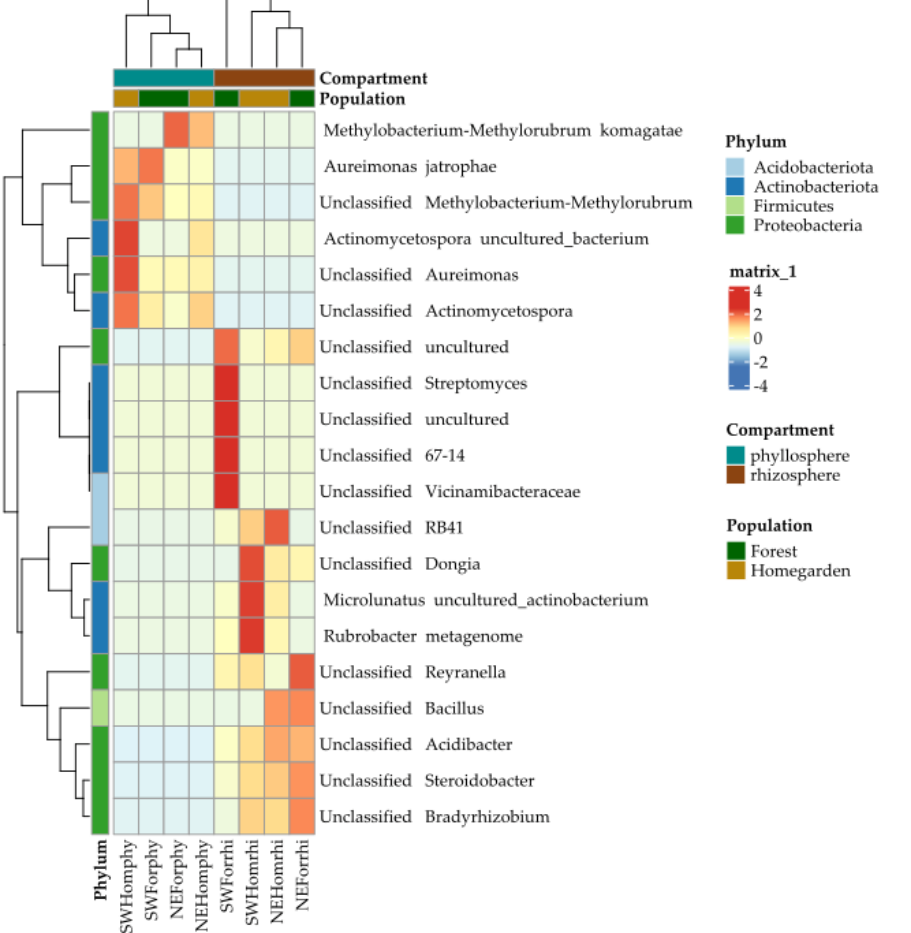
Figure 7. Heatmap of the microbiota of bacteria from the phyllosphere and rhizosphere in Yucat á n’s forest and homegarden populations of Cordia dodecandra